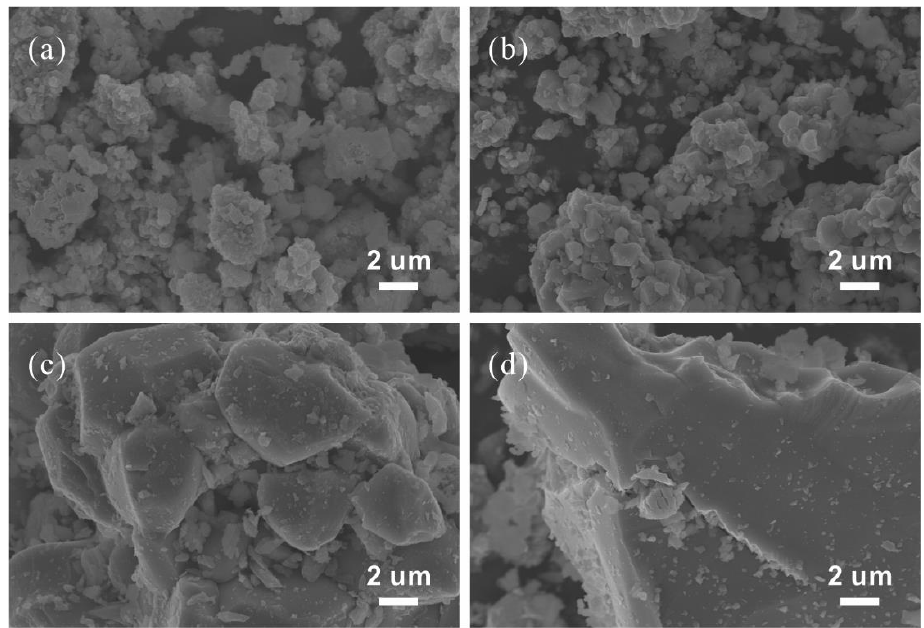
Figure 4. SEM images of LiNi 0.5 Co 0.2 Mn 0.3 O 2 synthesized at different temperatures: ( a ) 800 °C, ( b ) 900 °C, ( c ) 1000 °C and ( d ) 1100 °C.